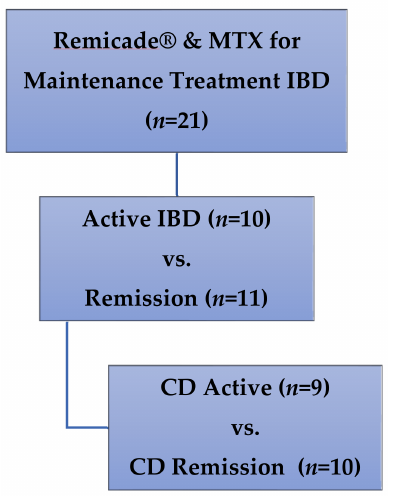
Figure 3. Patients included in this secondary analysis of methotrexate polyglutamates in pediatric IBD. MTX: methotrexate, IBD: inflammatory bowel disease, CD: Crohn’s